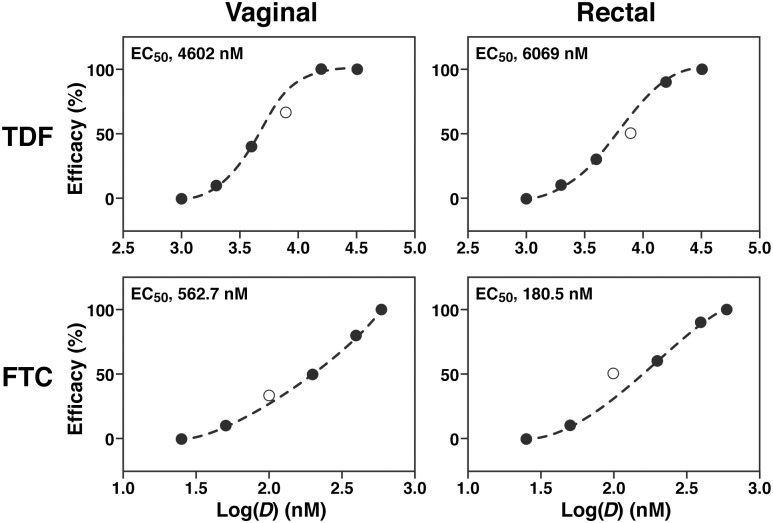
Dose-response curves for TDF and FTC single-drug infection studies.Plots of efficacy versus concentration of TDF or FTC dose applied prior to HIV challenge for Round 1 (broad concentration range, open circles) and Round 2 (narrow concentration range, filled circles). Dashed lines are fits to a sigmoidal dose-response (variable slope) model used to calculate EC50 of TDF and FTC providing protection against vaginal and rectal HIV challenges in humanized BLT mice.